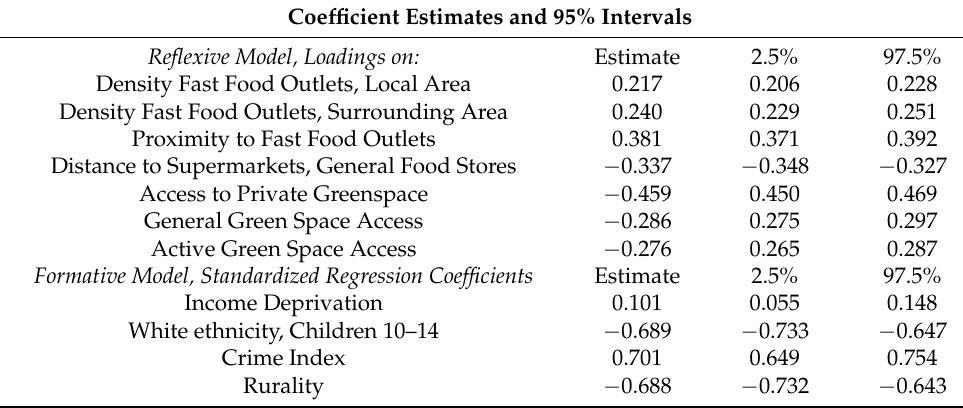
Table 1. First Measurement Model for Obesogenicity.